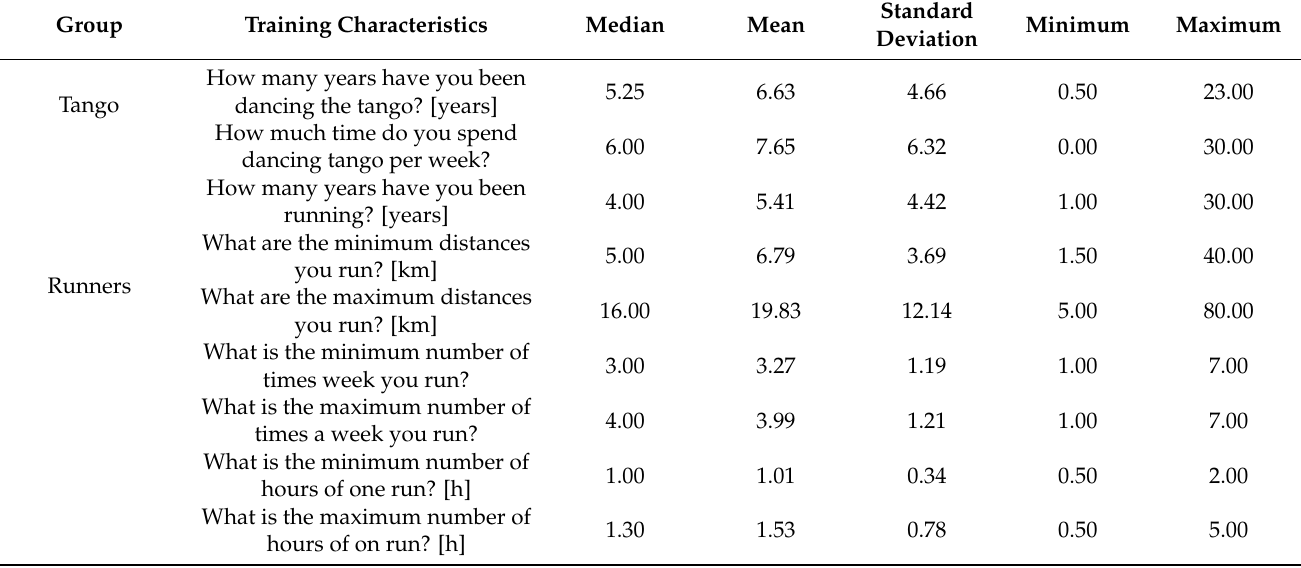
In the physically active groups, the dancers had been dancing tango for 5.25 years for 6 h a week, while the runners had been training for 4 years for 3–4 h a week, covering distances from 5 to 16 km (Table 2). Table 2. Training characteristics of the tango dancing women ( N = 94) and the runners ( N = 215). Group Training Characteristics Median Mean